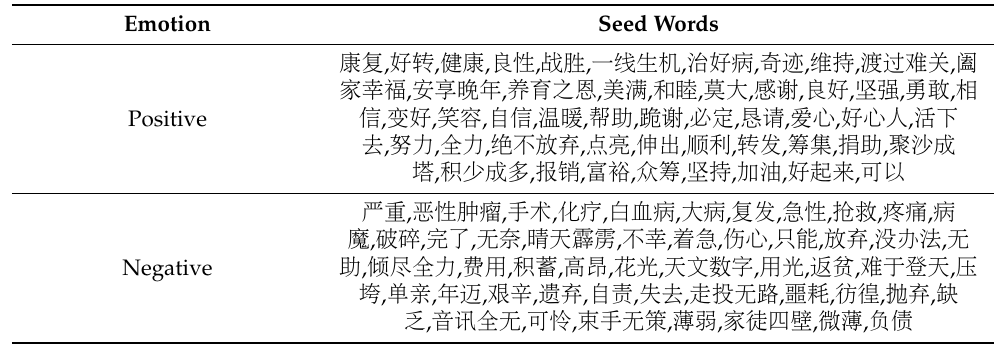
Table 3. Sentimental seed words.